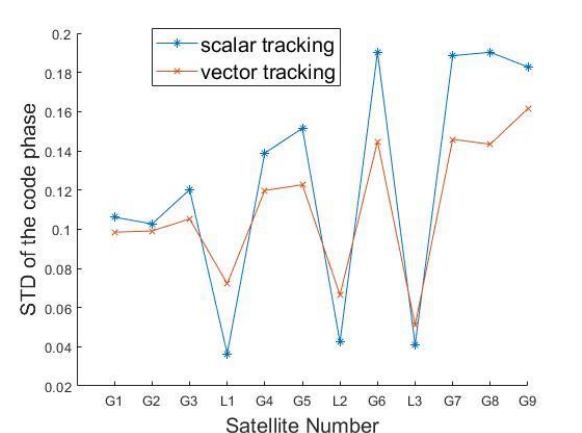
Figure 7. Comparison of the standard deviation of the code phase error between VTL and STL